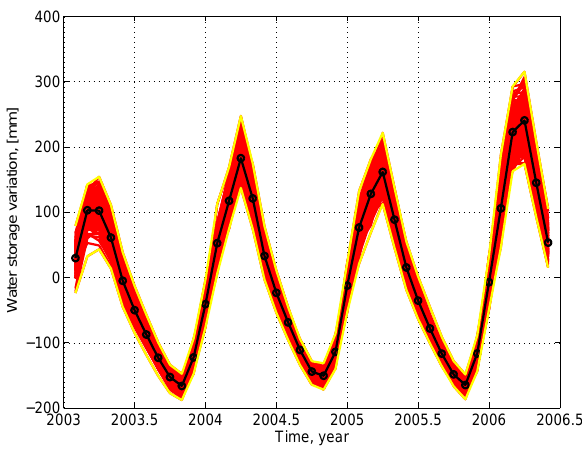
Fig. 6. Water storage variations (in red) averaged over the upper Zambezi basin from the Monte Carlo simulation (200 realizations, 30% noise in rainfall numbers). Mean water storage is given in black.